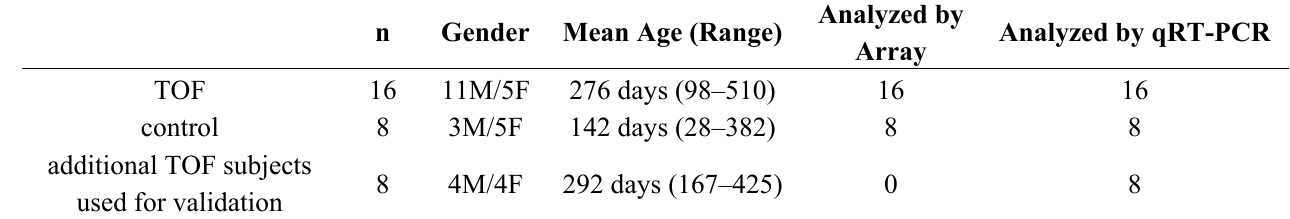
Table 1. Age and Sex of